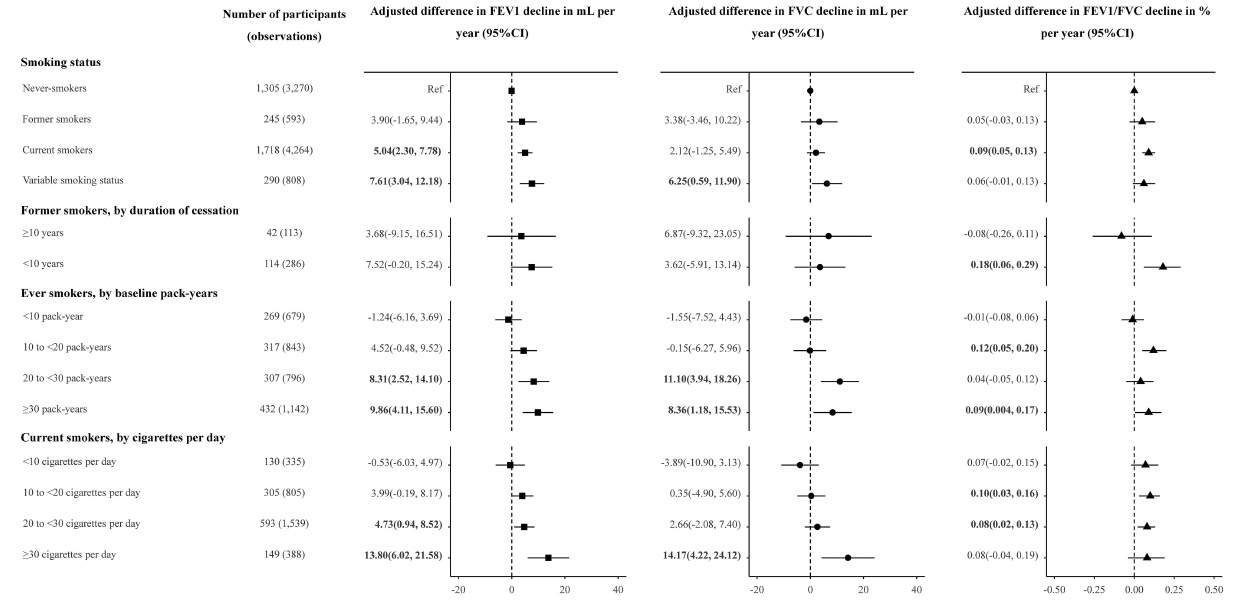
FIGURE 1 | Adjusted association between smoking status, duration of smoking cessation, cumulative and current cigarette consumption, and lung function decline in the longitudinal analysis. FEV 1 , forced expiratory volume in 1s; FVC, forced vital capacity; CI, confidence interval. Linear mixed models were used to test associations with repeated measures of FEV 1 , FVC and FEV 1 /FVC. Participants with variable smoking status were excluded from analyses of duration of smoking cessation and of cumulative and current cigarette consumption. Adjusted effect estimates for smoking exposures, relative to never-smoking, were generated with models adjusted for the smoking parameter, age, age 2 , height, weight, BMI, and alcohol consumption, hypertension, diabetes, TG, TC, total bilirubin at baseline. Multiplicative interactions with age were modeled for covariates. The effect estimate for smoking-exposure multiplied by age was interpreted as the association of the smoking exposure with annualized lung function